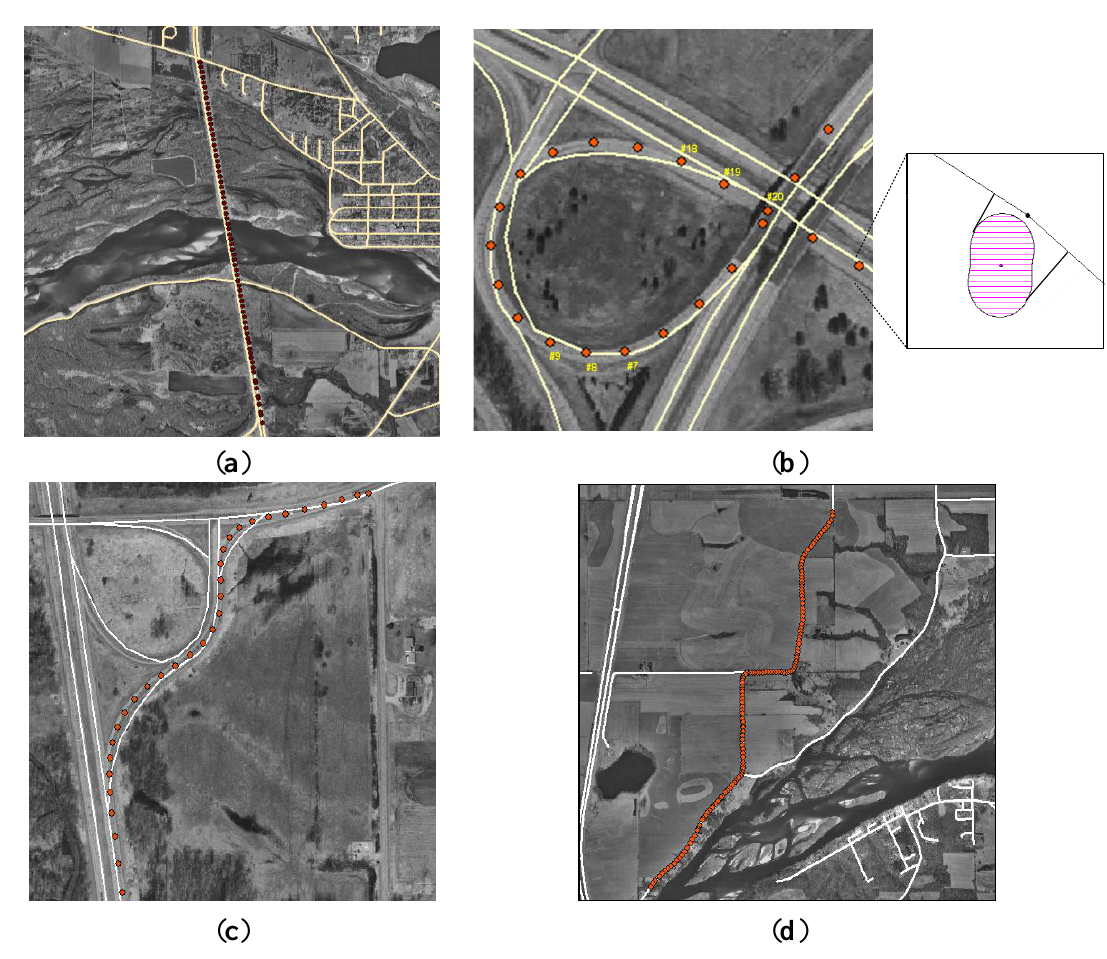
Figure 6. DGPS data points and roadway centerline maps on orthophotos. ( a )